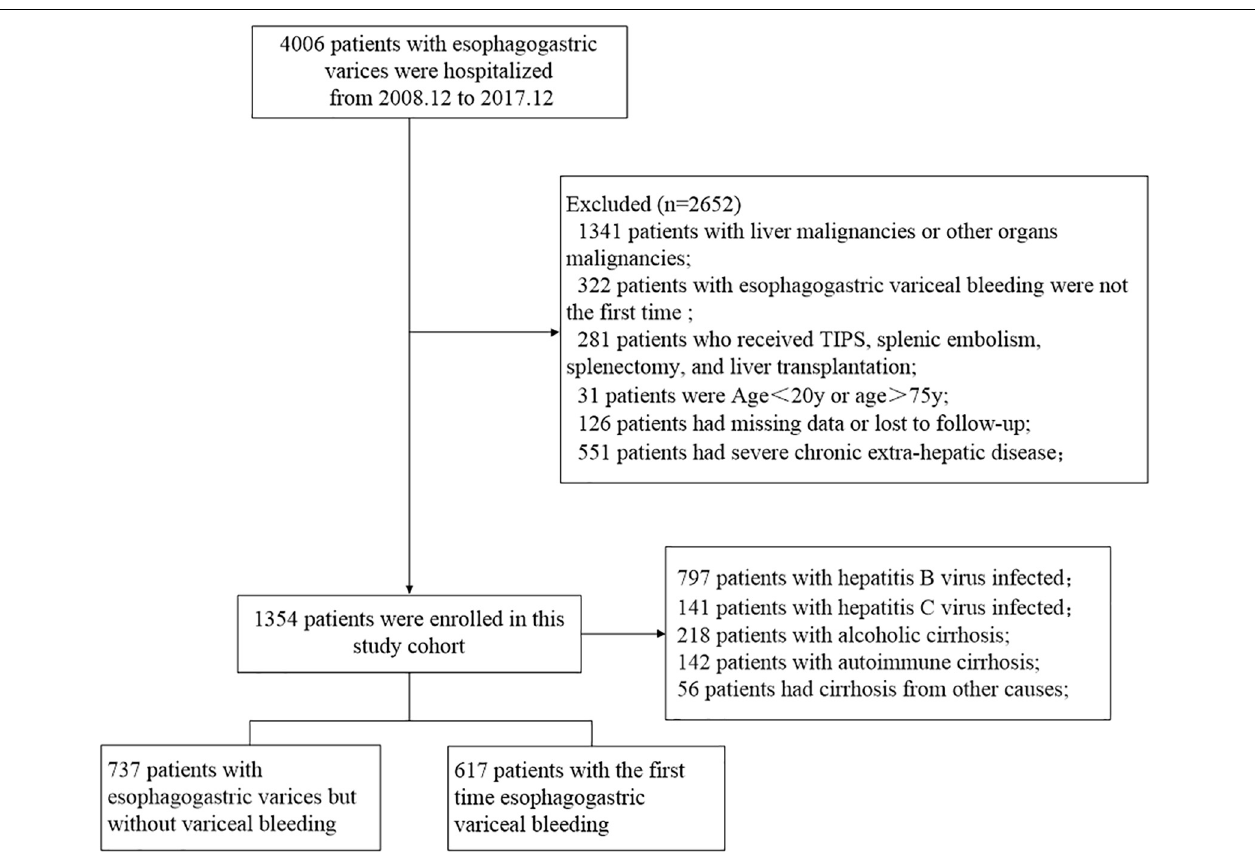
FIGURE 1 | Flowchart of the enrollment of patients with liver cirrhosis and esophagogastric varices.